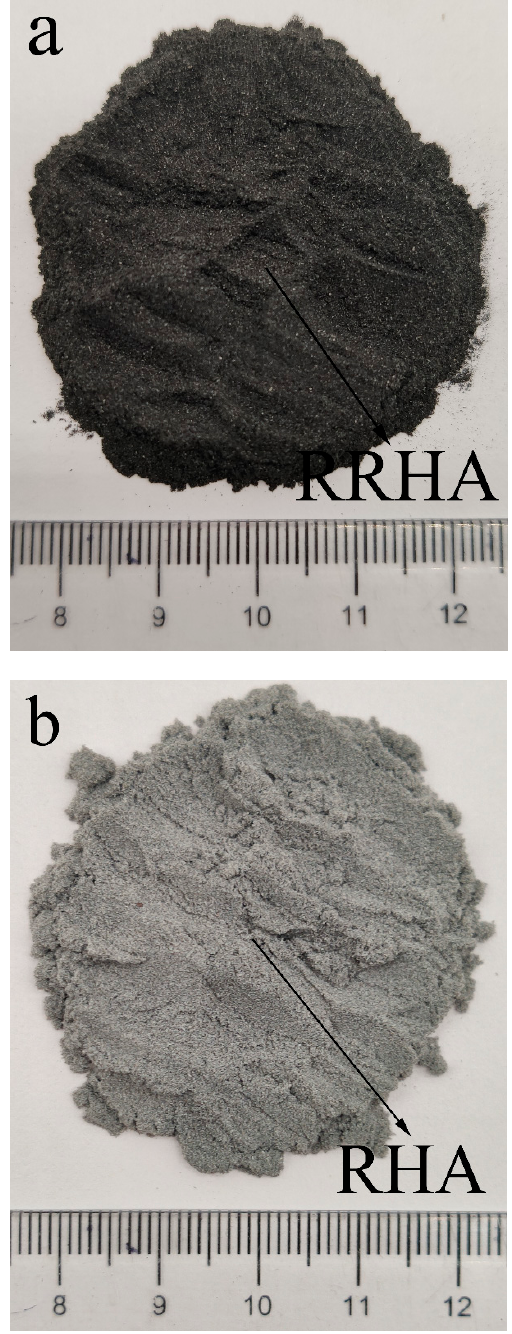
Figure 1. Digital photographs of RRHA and RHA: ( a ) RRHA; ( b ) RHA.